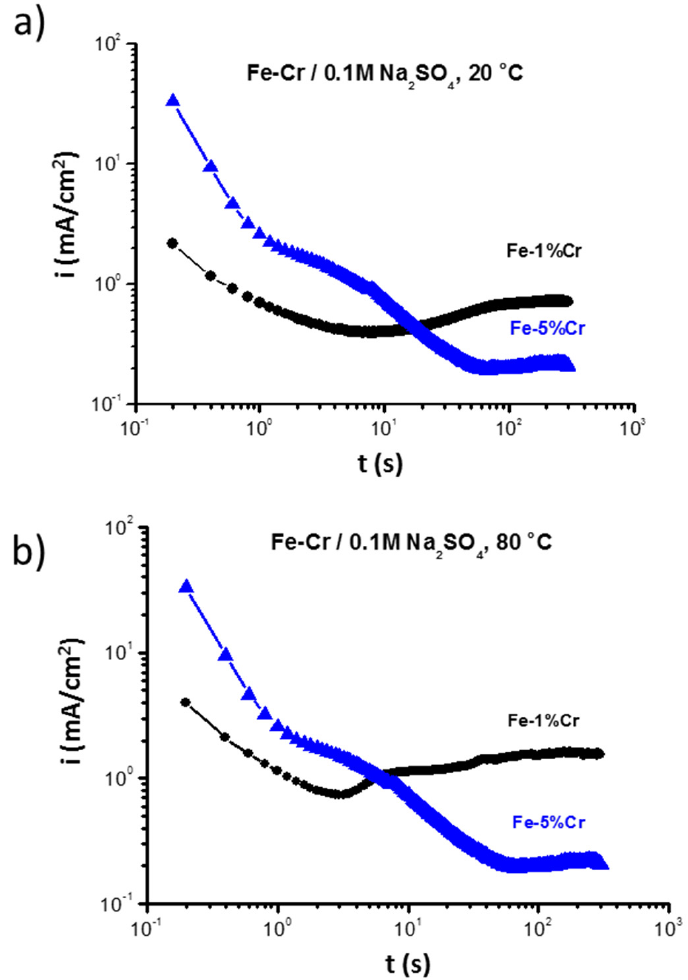
Figure 4. Chronoamperometry measurement performed for Fe-1%Cr and Fe-5%Cr at a constant potential ( E vs. SHE = − 0.5V) in 0.1M Na 2 SO 4 at ( a ) 20 °C and ( b ) 80 °C.